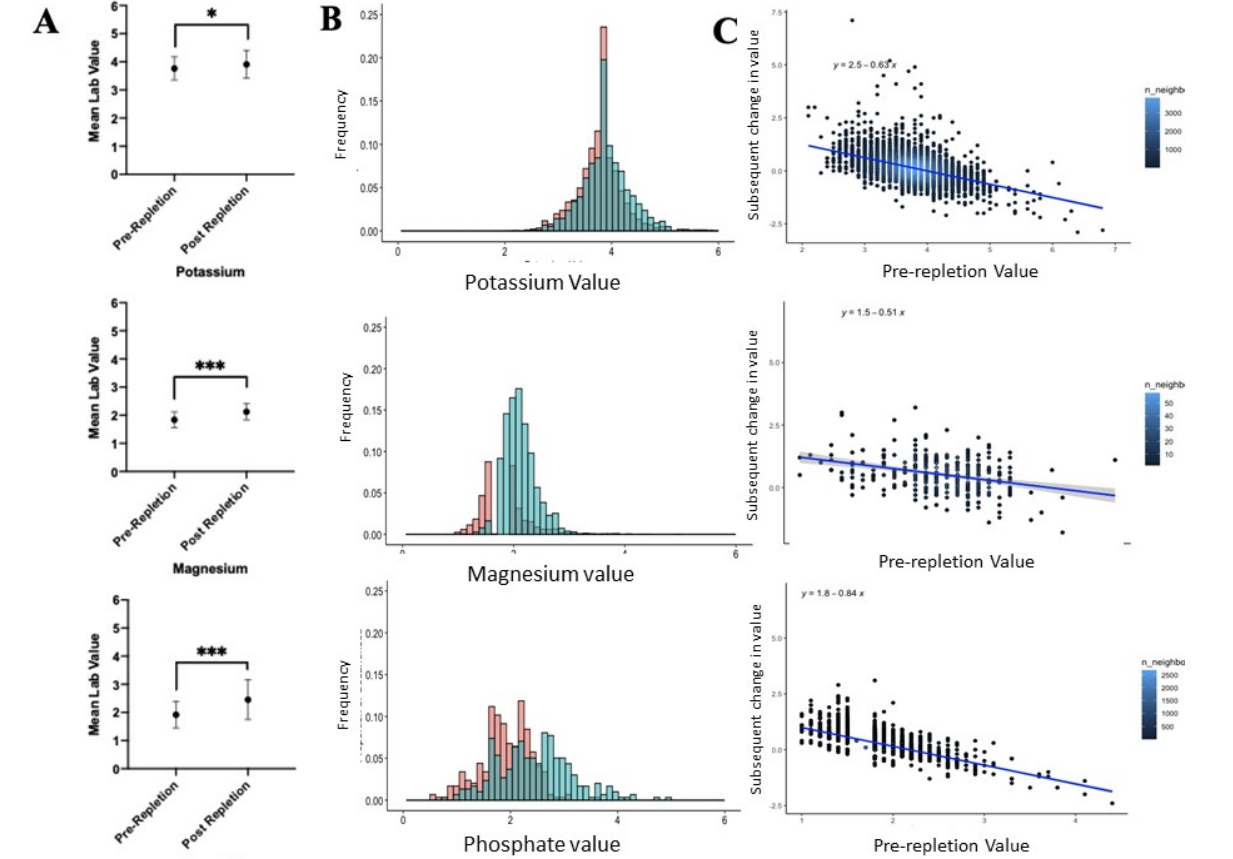
Figure 6. Electrolyte replacement resulted in a modest increase in potassium, while changes in magnesium and phosphate were much more pronounced when pre-post value were analyzed as averages ( A ) or as distribution of values. ( B ). For all of the electrolytes, the most significant variable determining post-repletion level was the preceding hypo-electrolyte state ( C ). * Refers to the effect size of the d-Cohen statistic, with * and *** corresponding to small, moderate, and large,